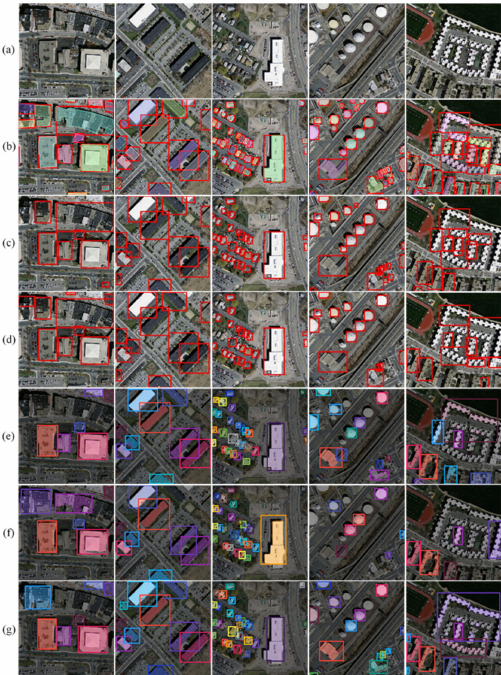
Figure 7. Results of building detection on the Massachusetts dataset. ( a ) Images. ( b )